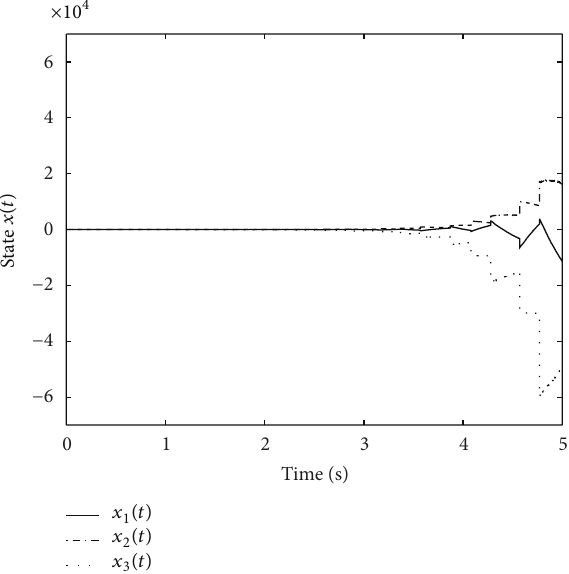
Figure 1: The state 𝑥(𝑡) of the system (23) versus time.